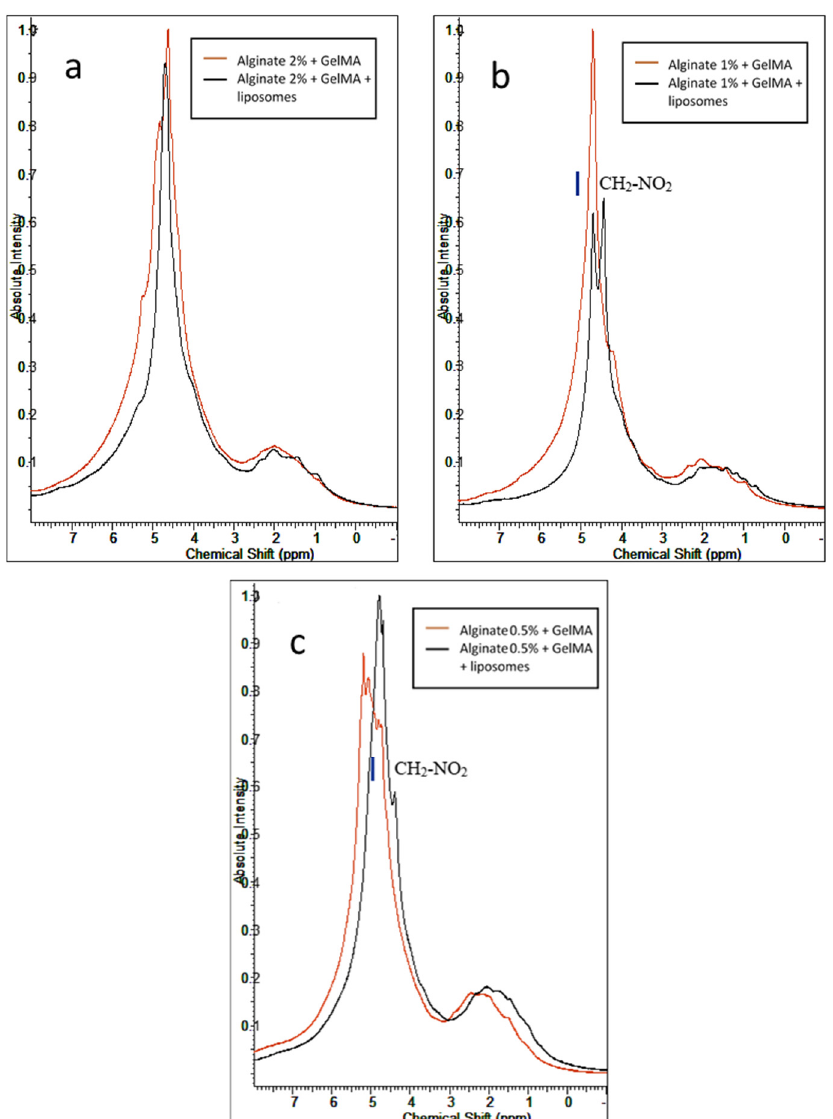
Figure 4. 1 HNMR spectra of the mixture between GelMA and alginate at different concentrations of alginate with and without nanoliposomes: ( a ) mixture with 2% alginate, ( b ) mixture with 1% alginate, and ( c ) mixture with 0.5% alginate.